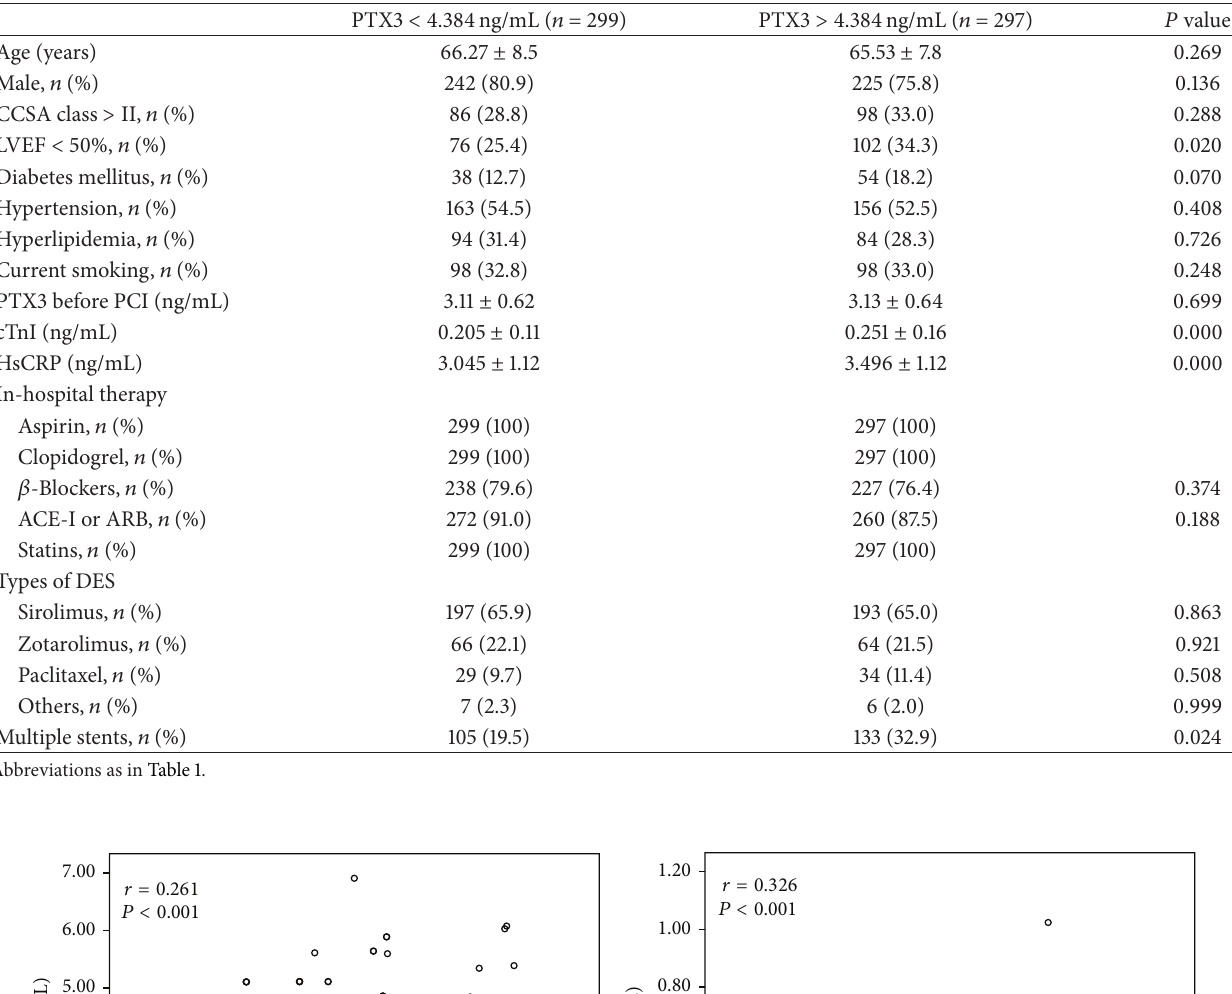
Table 2: Clinical characteristic according to median value of PTX3 at 24 h after PCI.